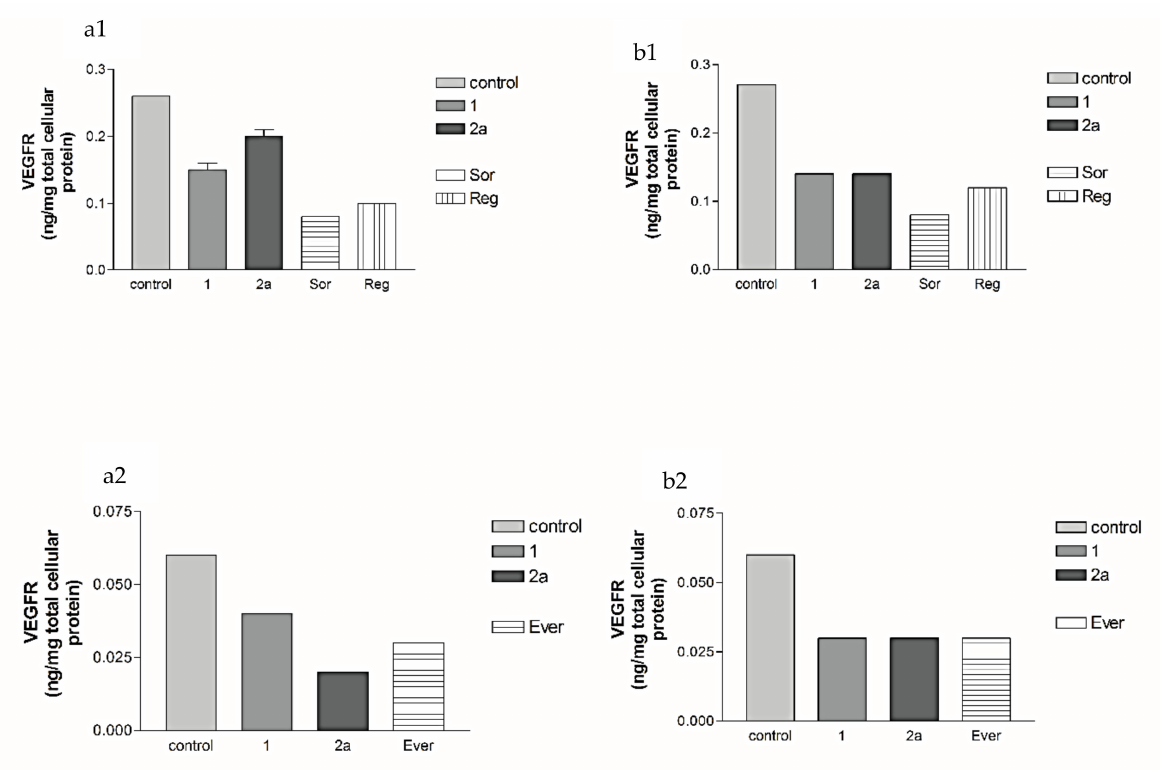
Figure 6. Effects of 1 and 2a and reference medications on VEGFR-2 protein expression level (ng/mg tissue protein) in HEPG2 and MCF-7, where ( a1 , a2 ) at 24 h and ( b1 , b2 ) 72 h, all therapies were provided for 3 successive days. Results are given as mean ± S.E.M.